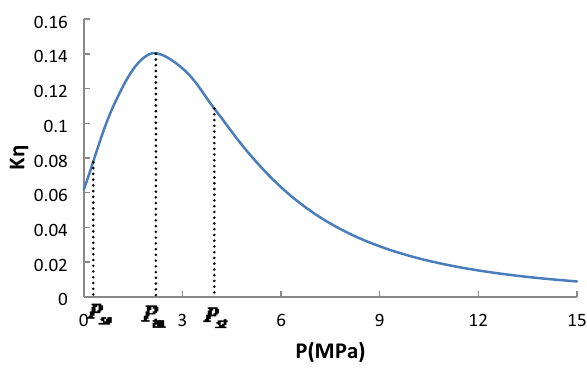
Fig. 3 The first derivative curve of the curvature of the desorption curve of sample